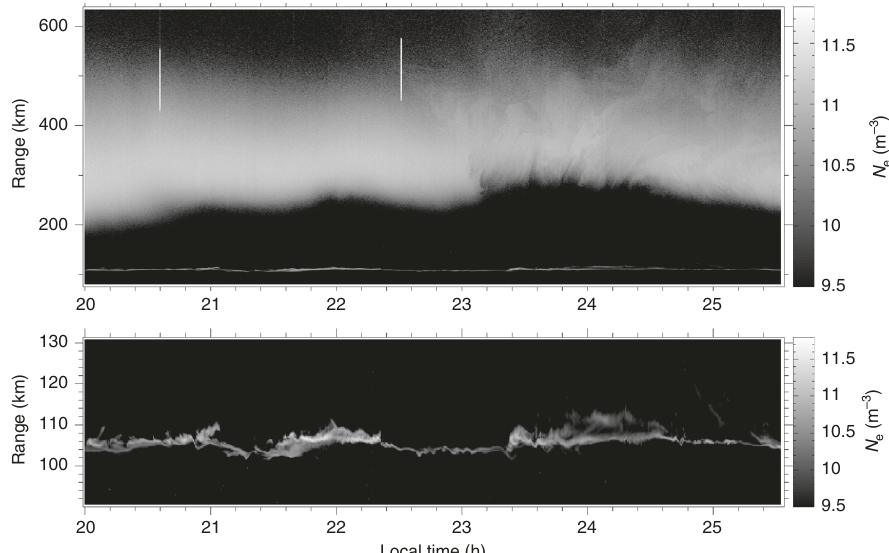
Fig. 1 Electron number density on the evening of 30 July 2016, represented as a function of altitude and local time in grayscale format. The fi gure shows both the E and F regions on the same scale and the E region in an expanded scale